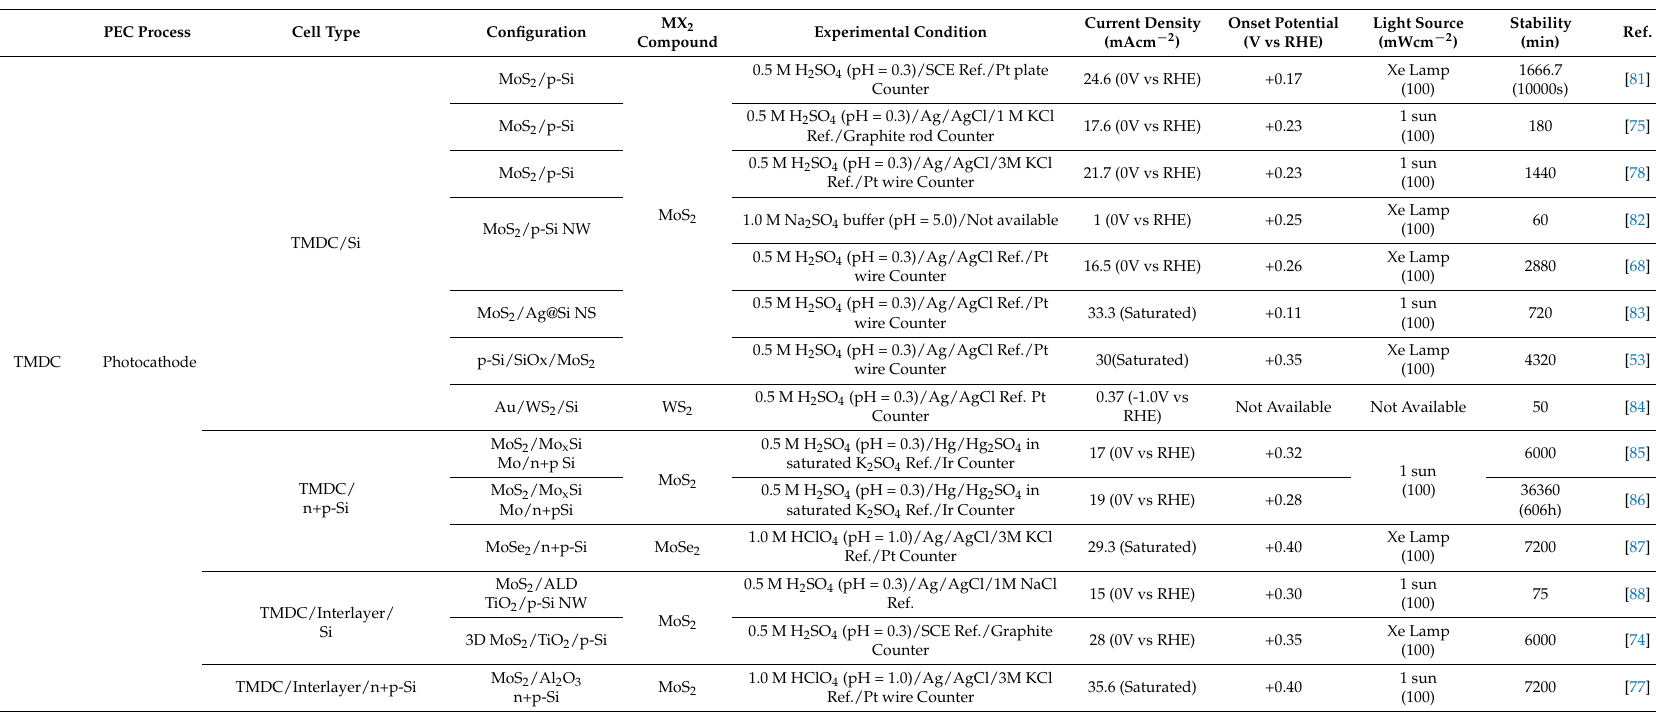
Table 1. Summary of the literature papers on the heterostructures of Si/TM(D)Cs for application in PEC water splitting (WS). Analyzed from Refs.